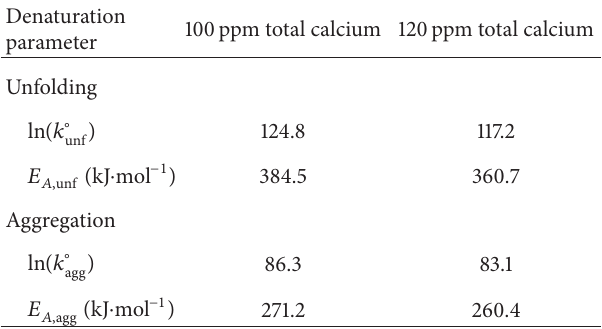
Table 3: Denaturation parameters at the two calcium concentra-